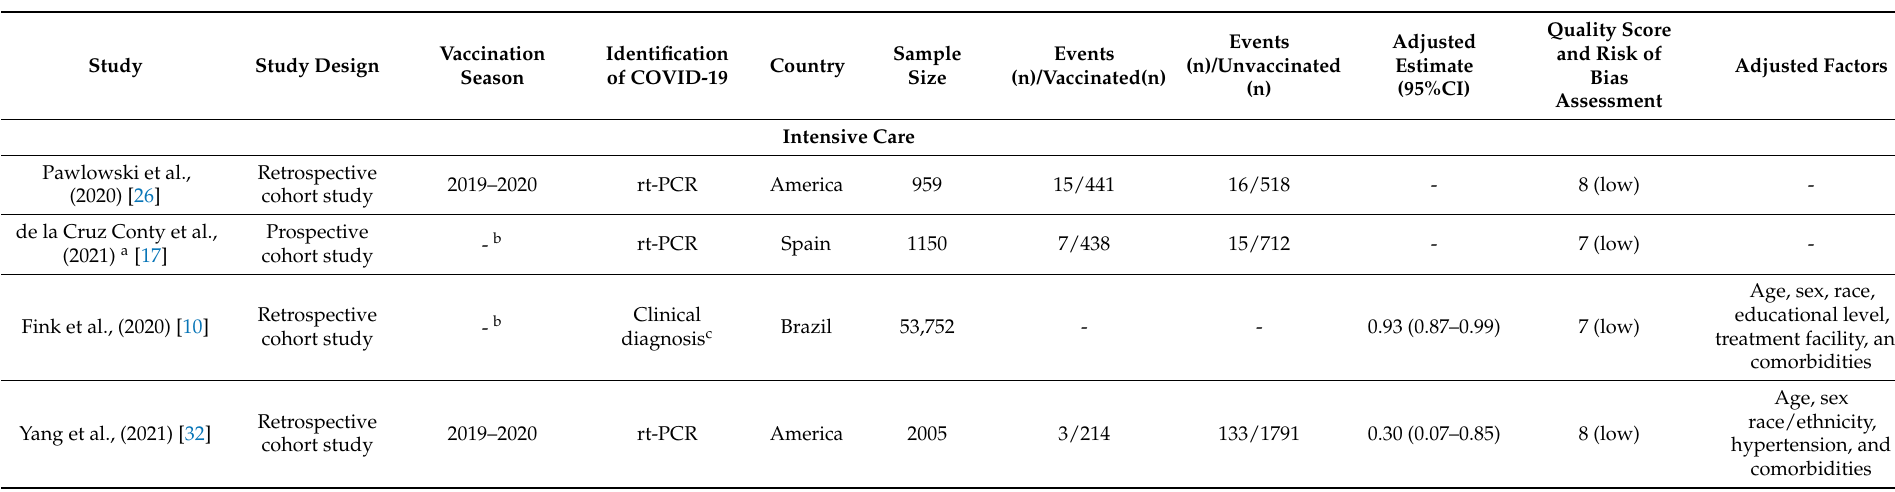
Table 2. Baseline characteristics of the six included studies that assessed the association between influenza vaccination and SARS-CoV-2